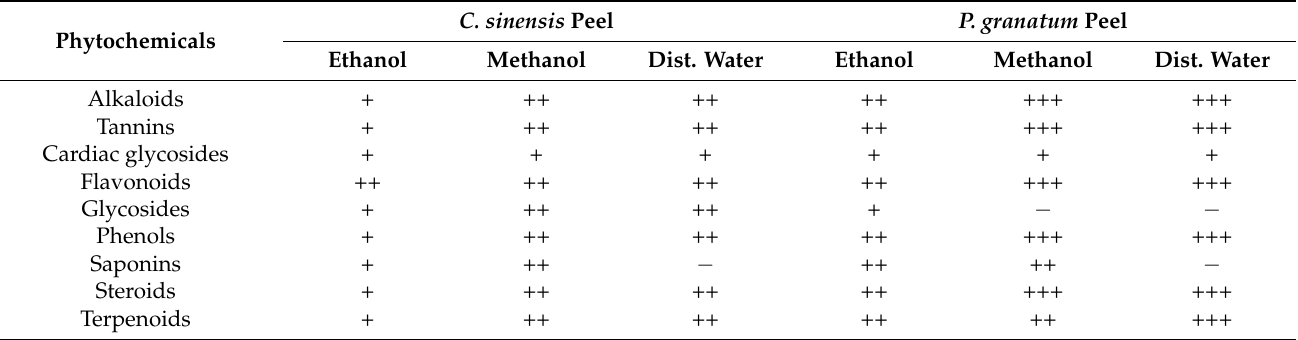
Table 4. Phytochemical screening of C. sinensis and P. granatum peel extracts.